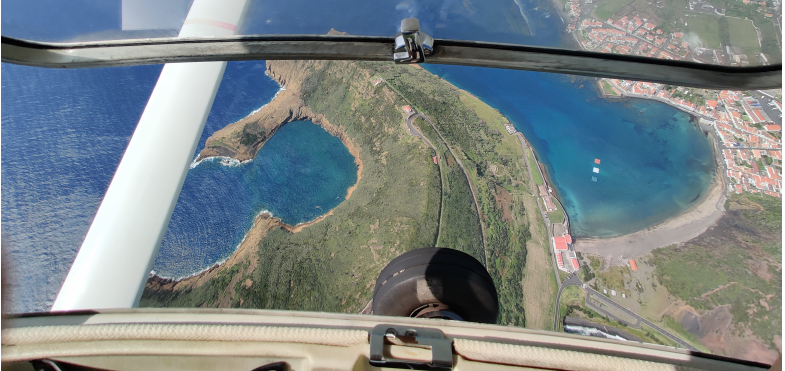
Figure 6. Image acquired from the aircraft during a flight with the artificial targets placed in the